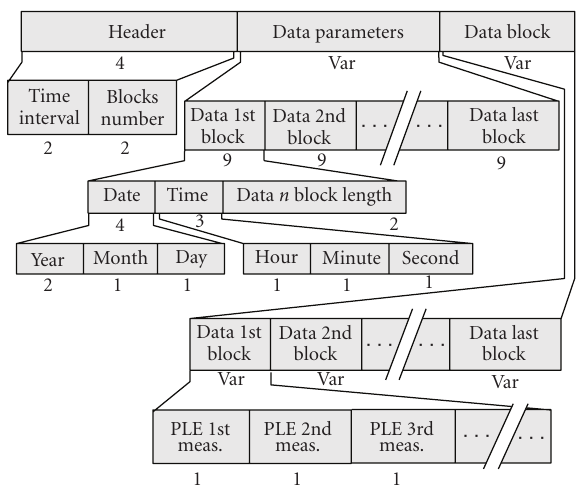
Figure 6: Overview of the data part holding the plethysmographic data